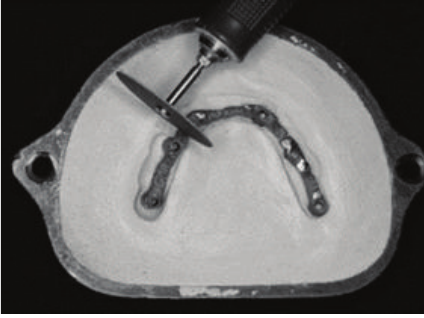
Figure 3: Splitting of the framework with a carborundum disc.